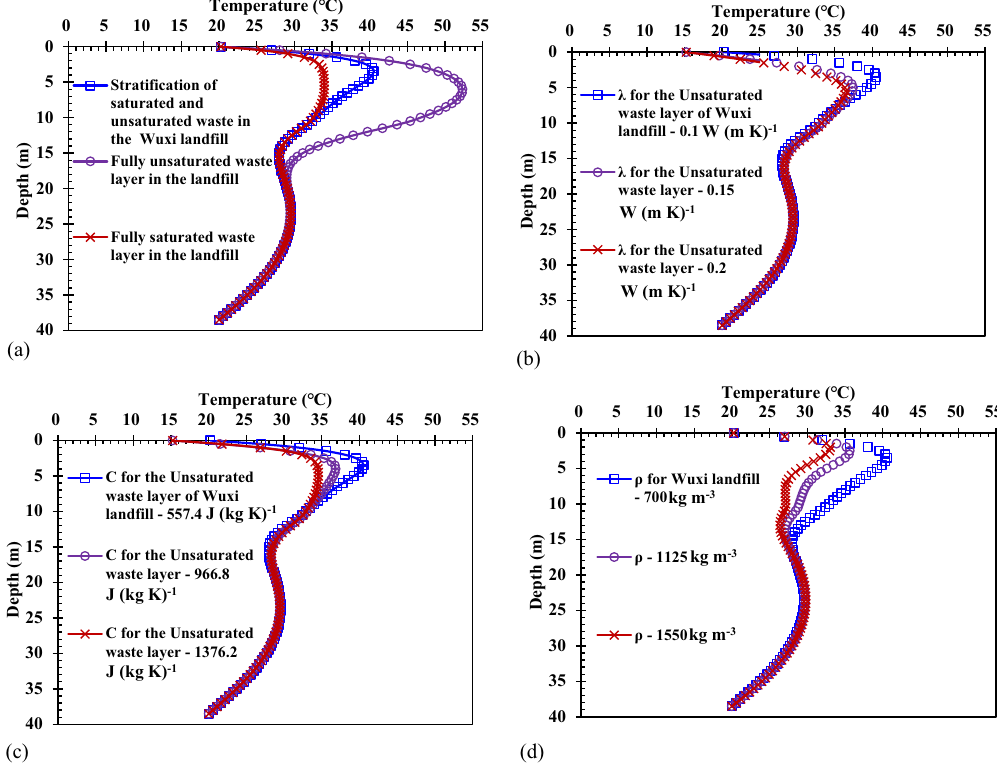
Figure 5. Comparison of the temperature distribution on Day 365 under the conditions of the different sensitive parameters: ( a ) stratification of the saturated–unsaturated waste; ( b ) heat conductivity of the waste ( λ ); ( c ) specific heat capacity of the waste ( C ); ( d ) density of the waste ( ρ